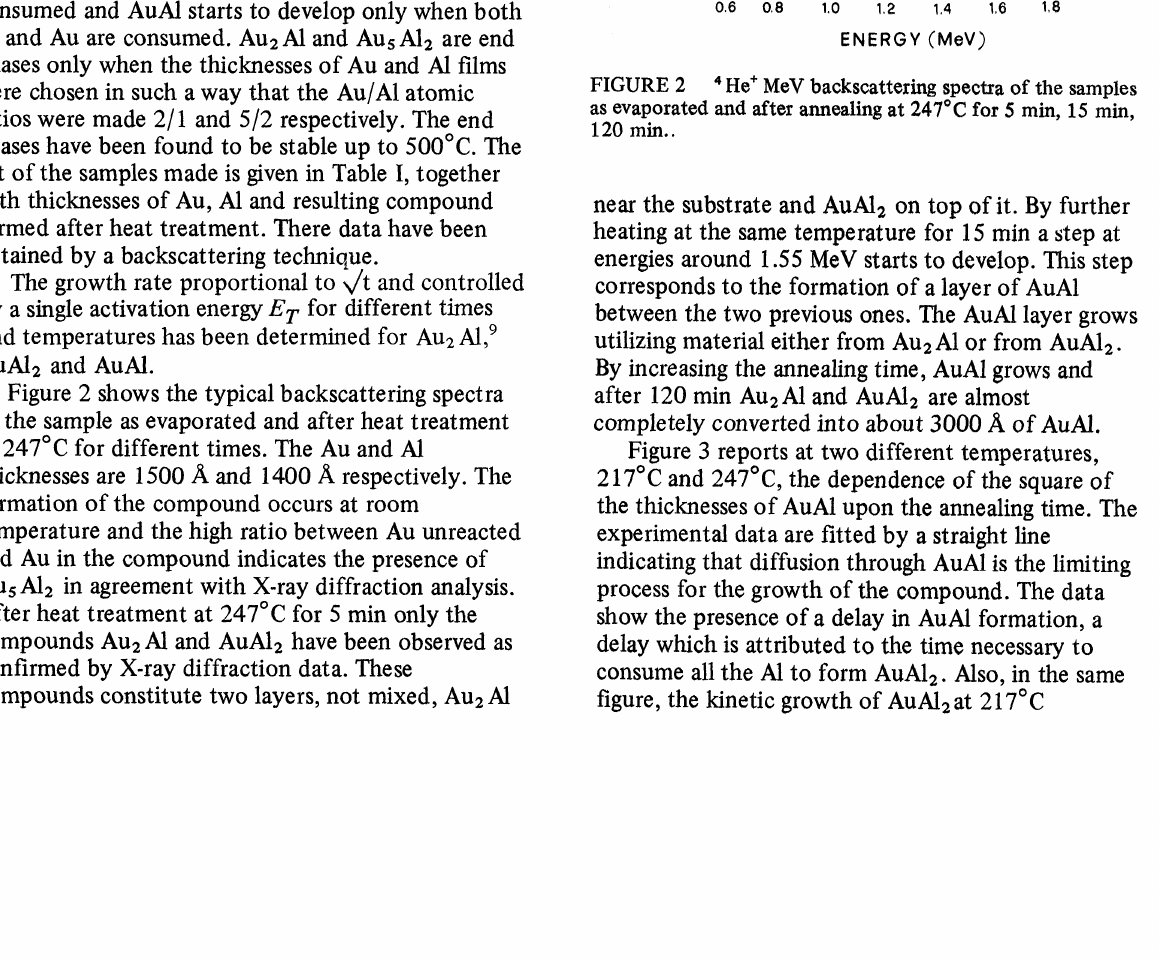
He* MeV backscattering spectra of the samples as evaporated and after annealing at 247C for 5 min, 15 min, 120